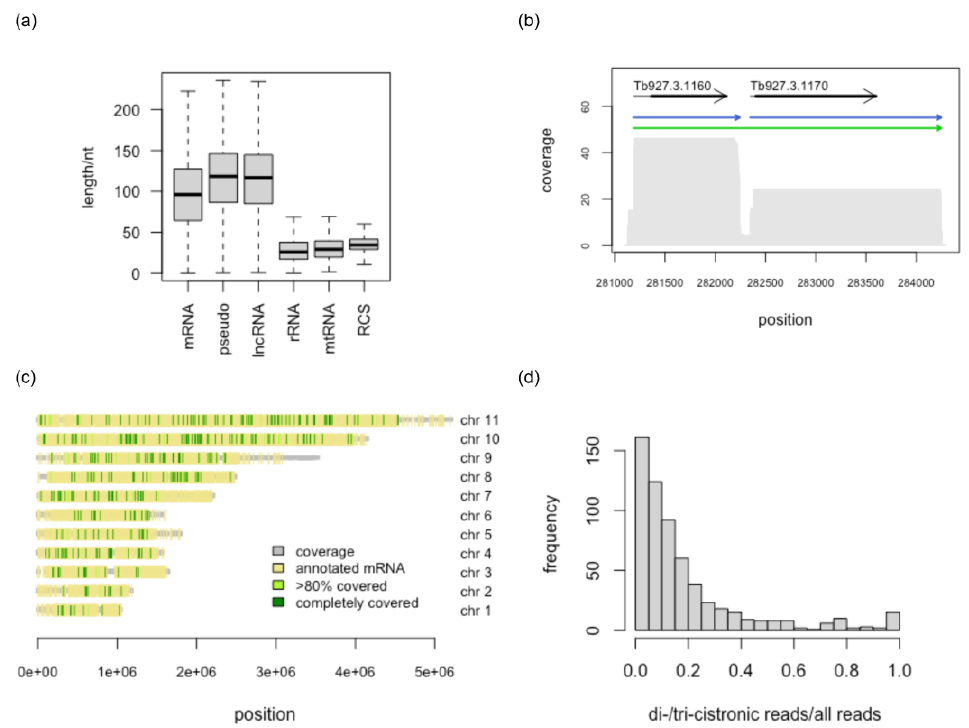
Figure 2. Transcript poly(A)-tail length distribution and characteristics of di- and tri-cistronic transcript reads. ( a ) RNAs are grouped based on the annotated features in TriTrypDB-52_TbruceiTREU927.gff distinguishing messenger (m)RNA, pseudogene-derived transcripts, long noncoding (lnc)RNAs, and ribosomal (r)RNAs, in addition to mitochondrial (mt)RNAs and the RNA-Calibrant-Strand (RCS) used during library preparation. Bold horizontal lines represent the median. ( b ) Full-length read coverage profile of a representative example of a di-cistronic transcript (green arrow) involving the annotated T. brucei genes Tb927.3.1160 and Tb927.3.1170. Arrows in blue represent the monocistronic RNAs. Grey arrows are annotated genes and thick black lines specify coding sequences. ( c ) Genomic localization of all di- and tri-cistronic reads on the 11Mbp chromosomes (chr) of T. brucei . The color coding is described in the legend. ( d ) Bar graph of the ratio of di- and tri-cistronic transcript reads over all full-length reads that map to annotated